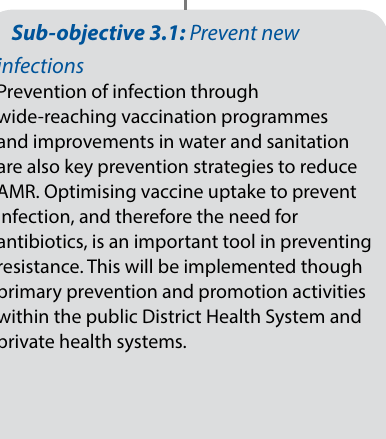
Figure 2. The strategic objectives, pertaining to infection prevention and control, per the SA AMR framework strategy